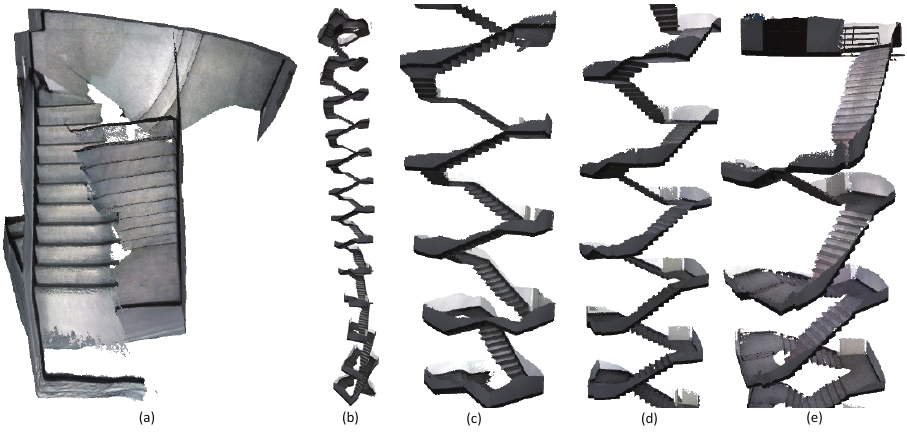
Figure 11. The reconstruction results of the stairs on the 1st–12th floor in a department. ( a ) is produced by BundleFusion [33]. The system failed and the generated surface was unpleasant. ( b ) is the result generated by our system. ( c – e ) give the surface details of the stairs on the 1st–12th floor. More than 10 million points were produced by our system. The frame rate of our system was kept high and constant during the